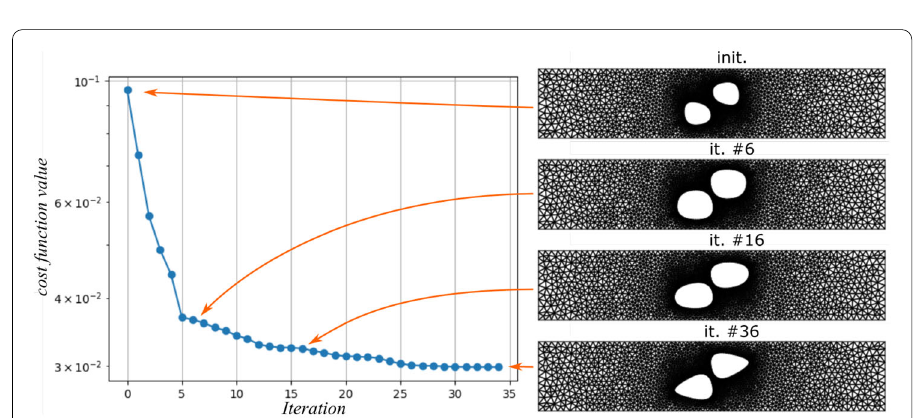
Fig. 15 Example of the orthotropic specimen with two holes: evolution of the cost function value and specimen shape during the second optimization process (after the remeshing